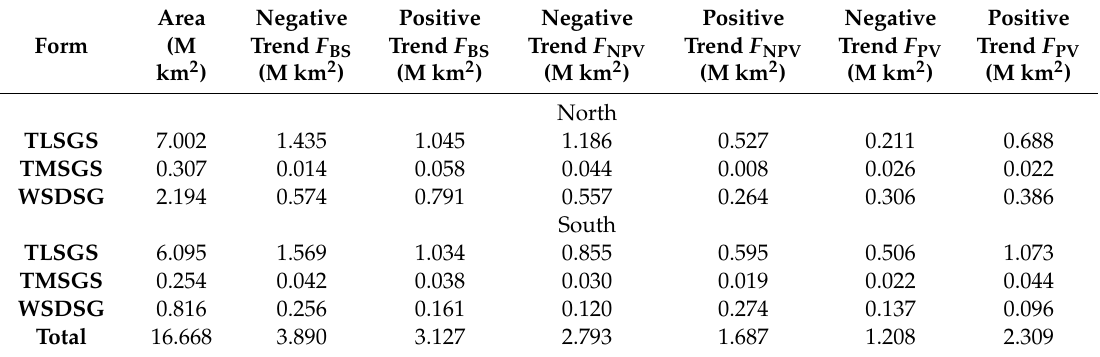
Table 2. Area of Savanna Woodland and Scrub Grassland (SWSG) Divisions exhibiting significant